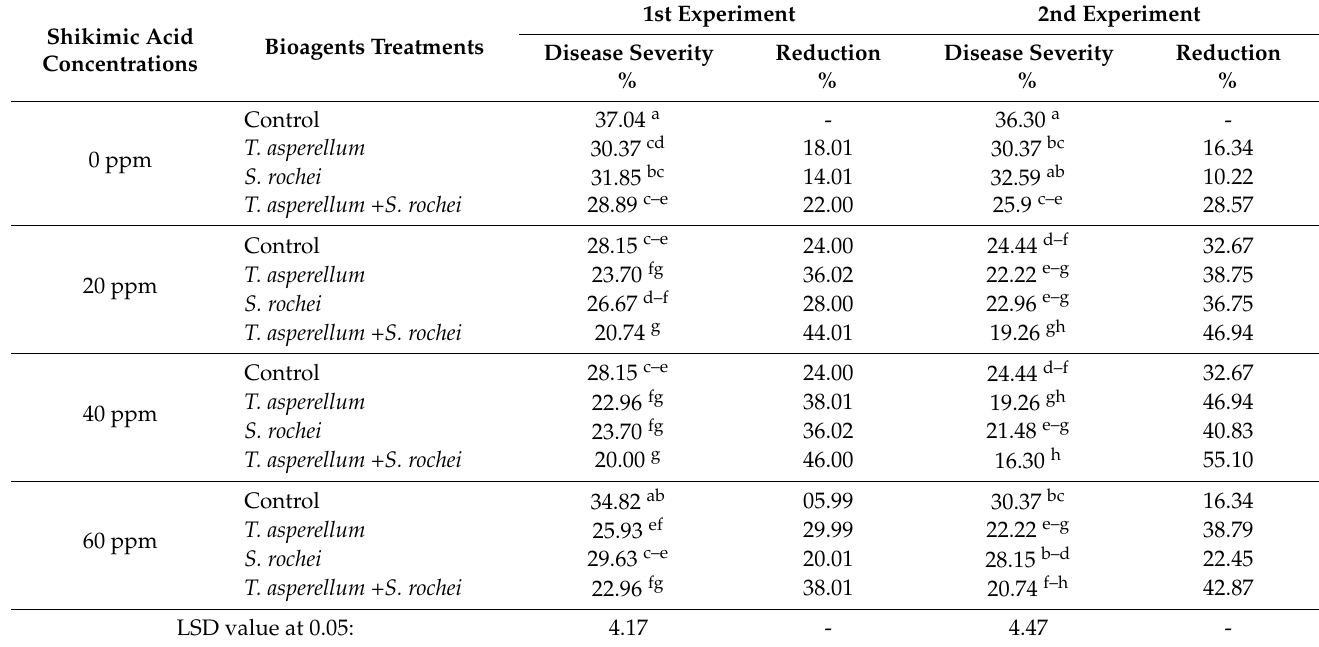
Table 1. Effect of the interaction between seed priming of shikimic acid (0, 20, 40, 60 ppm) and foliar applications with S. rochei (SR), T. asperellum (TS), S. rochei + T. asperellum (SR + TS), and water (control) on powdery mildew severity % on squash plants during the first and second